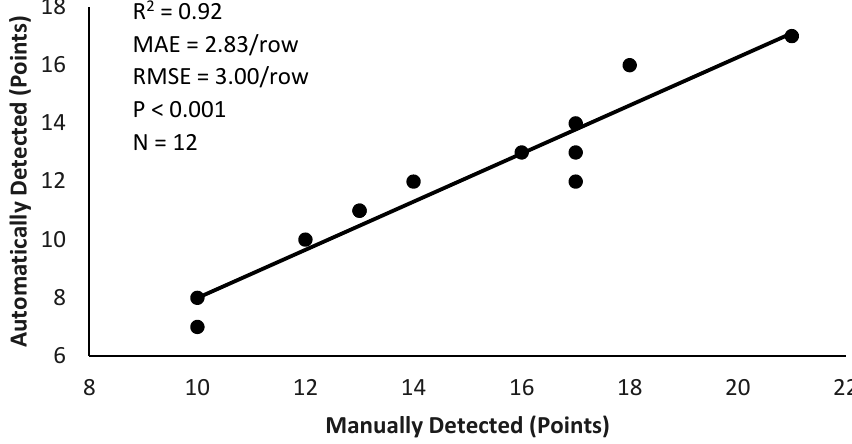
Figure 11. Correlation between manually and automatically detected points for field site III.